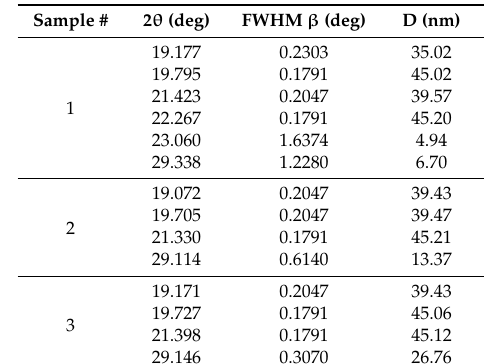
Table 1. Results of the calculations of grain (crystallite) size for the filtered/extracted crystalline c-Mn(BH 4 ) 2 , from three extracted (2NaBH 4 + MnCl 2 ) samples. The Bragg diffraction peak positions 2 θ (deg) and full width at half maximum (FWHM) for a corresponding Bragg peak and crystallite (grain) size, D, are listed.